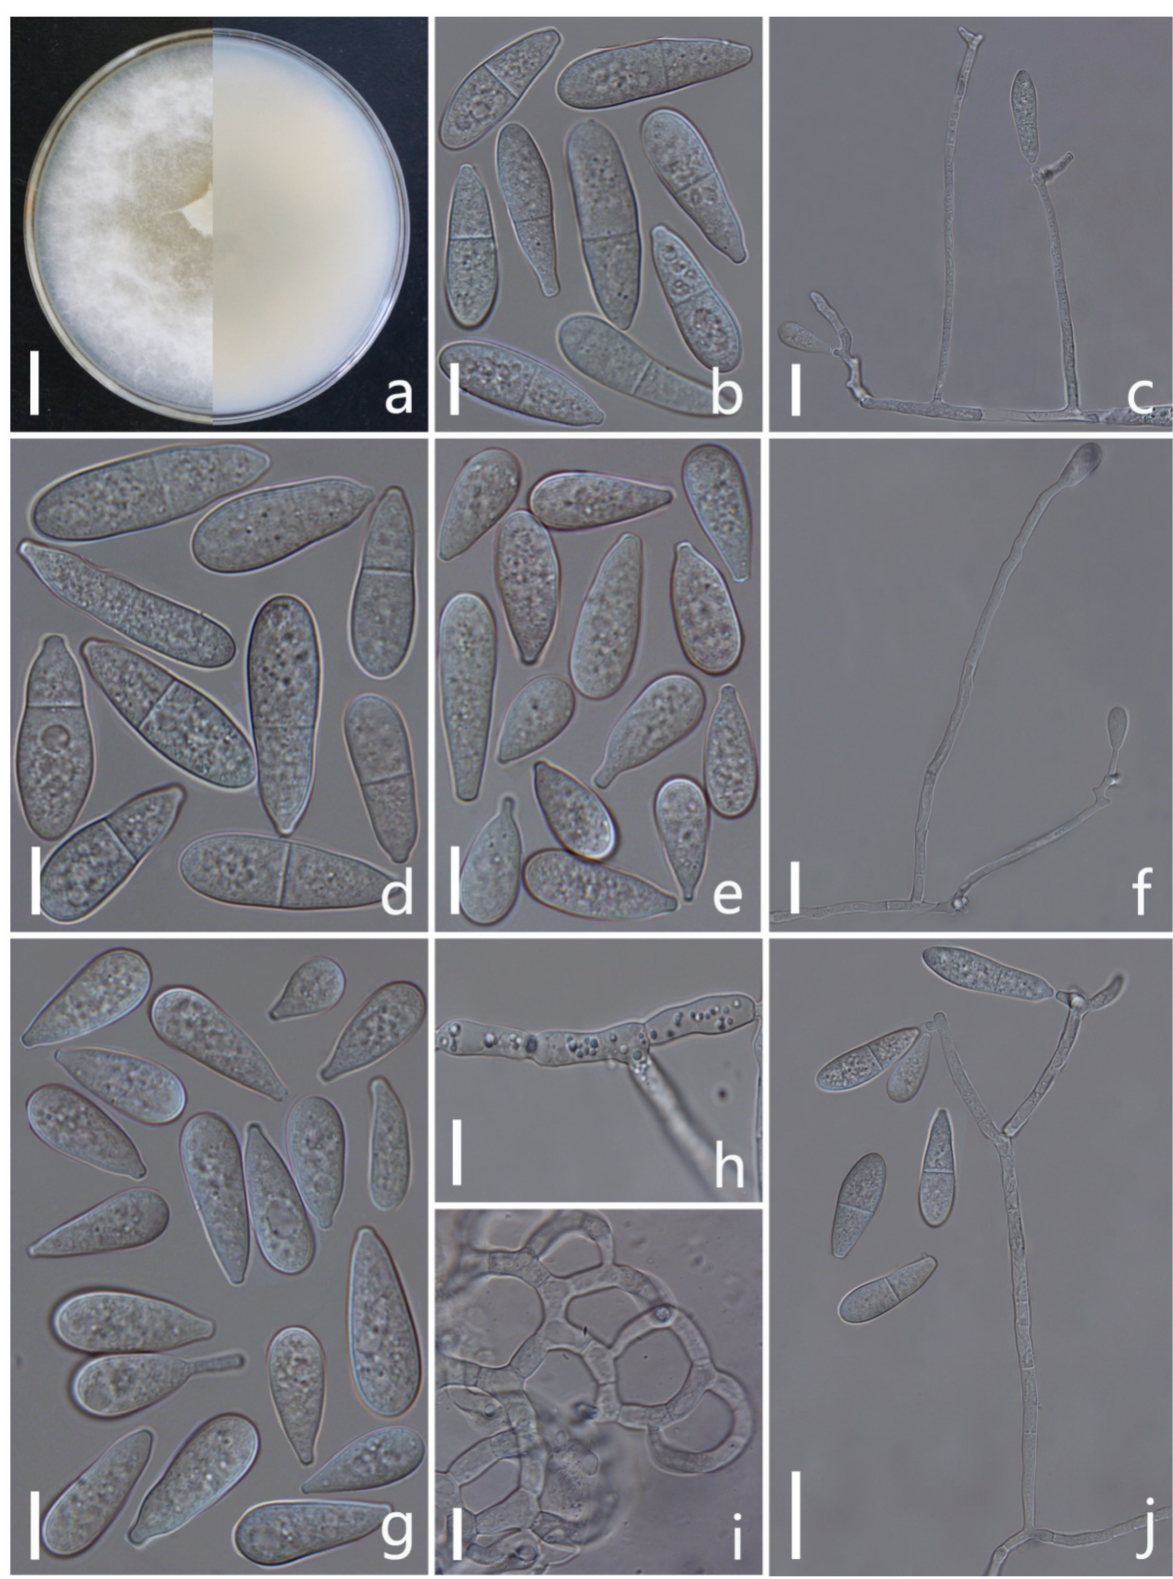
Figure 2. Arthrobotrys eryuanensis (CGMCC3.19715). ( a ) Colony. ( b , d ) Macroconidia. ( e , g ) Microconi- dia. ( c , f , j ) Conidiophores. ( h ) Chlamydospores. ( i ) Trapping device: adhesive networks. Scale bars: ( a ) = 1 cm, ( b , d , e , g – i ) = 10 µ m, ( c , f , j ) = 20 µ